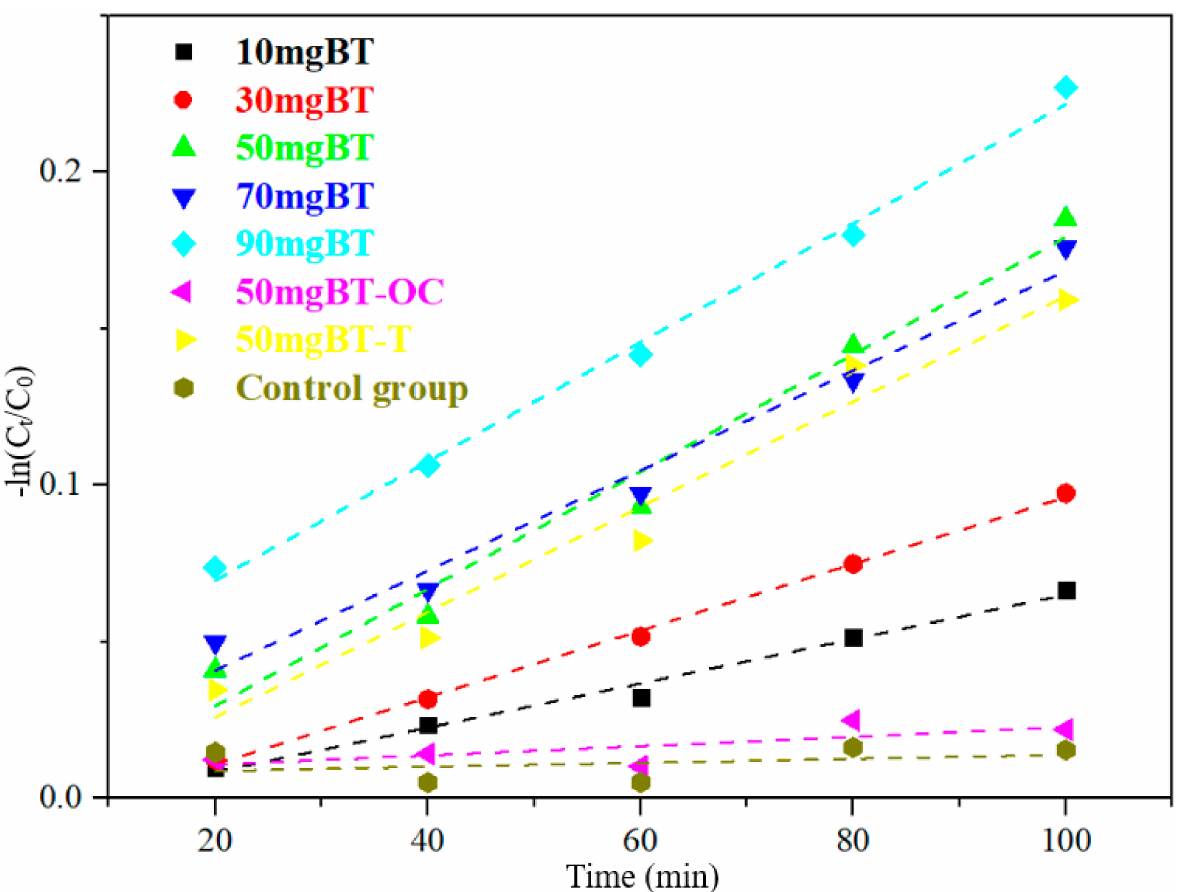
Figure 6. Kinetics fitting curves for the adsorption of RhB.